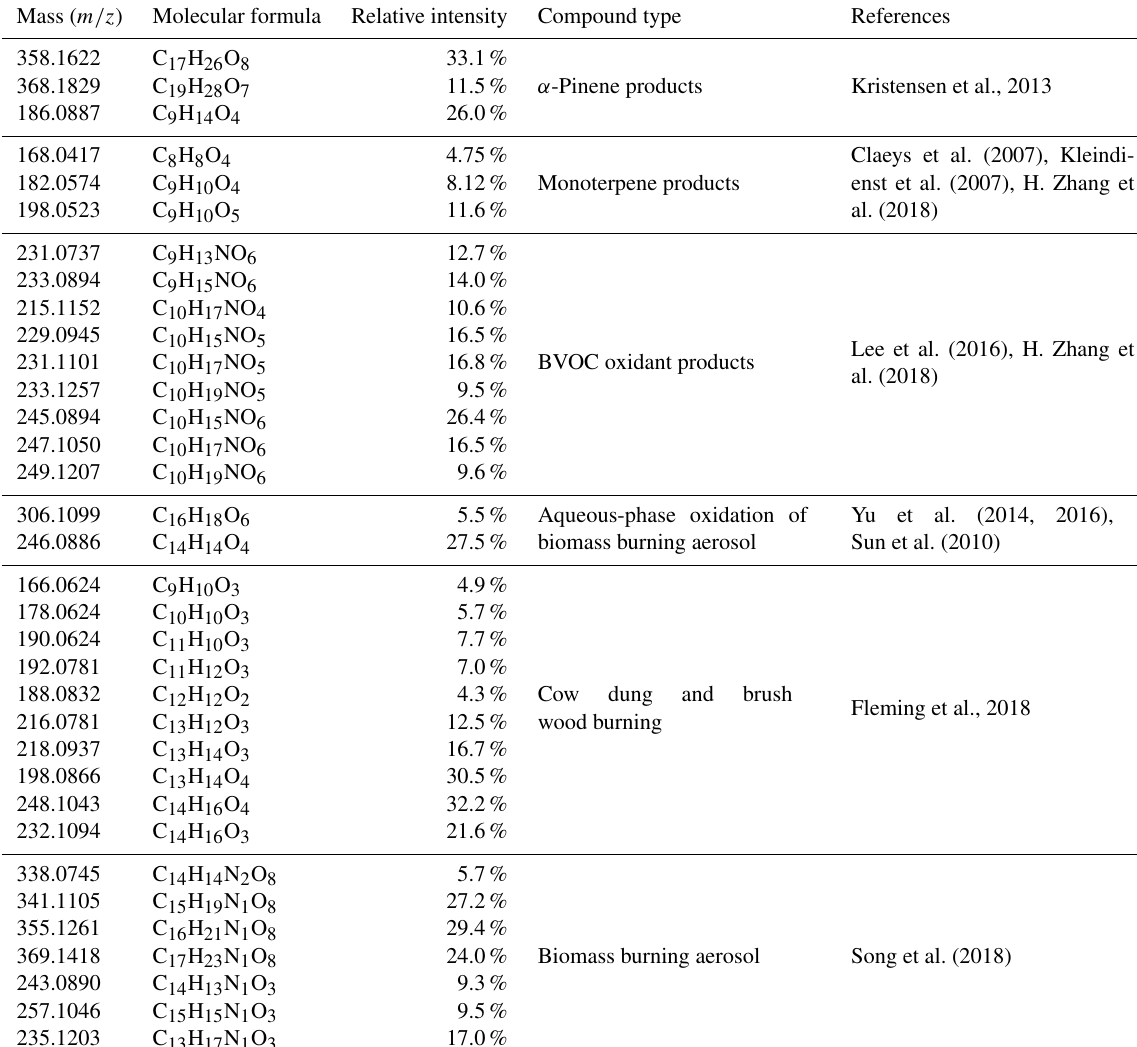
Table 3. List of identified BVOC products and biomass-burning-emission-related compounds in this study. Mass ( m/z ) Molecular